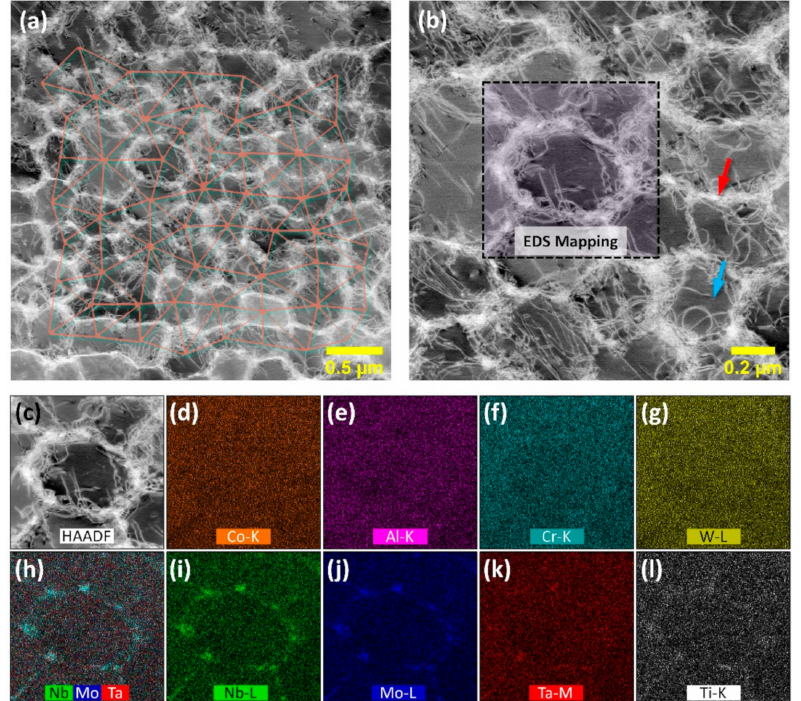
Figure 2. ( a ) Dark-field scanning transmission electron microscopy (DF-STEM) micrograph of the as-built MAD542 microstructure overlapped with cellular / dendritic arm spacing measurements in sub-micron size. ( b ) Enlarged view of the cellular / dendritic structure. ( c – l ) EDS mapping results of the scanning area as shown as the box in ( b ): ( c ) High-angle annular dark-field (HAADF) imaging, ( d ) Co-K map, ( e ) Al-K map, ( f ) Cr-K map, ( g ) W-L map, ( h ) Nb-, Mo-, Ta-overlapping map, ( i ) Nb-L map, ( j ) Mo-L map, ( k ) Ta-M map, and ( l ) Ti-K